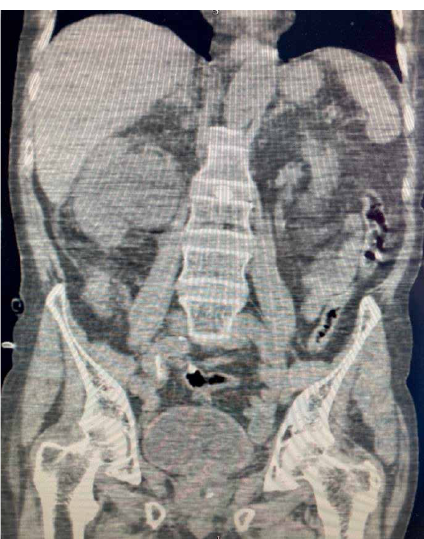
Figure 1: CT KUB showing significant right sided hydronephrosis along with perinephric fat stranding.